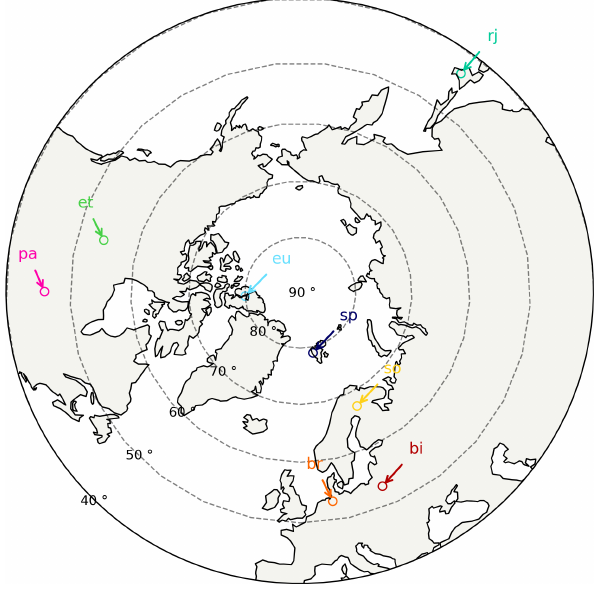
Figure 1. Map of the locations of all TCCON sites used in this